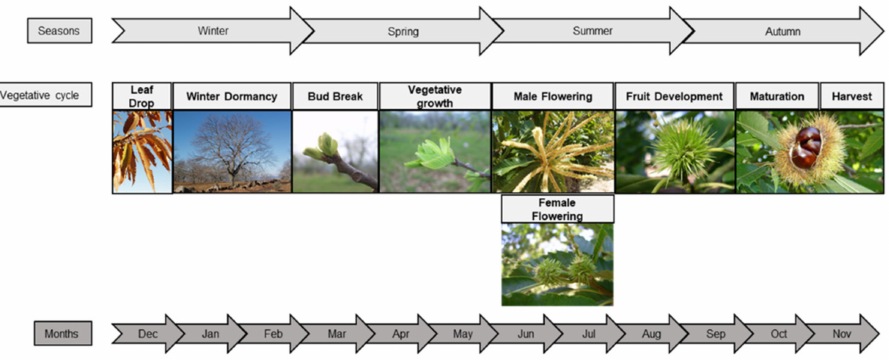
Figure 4. Chestnut tree phenology stages according to the extended BBCH general scale